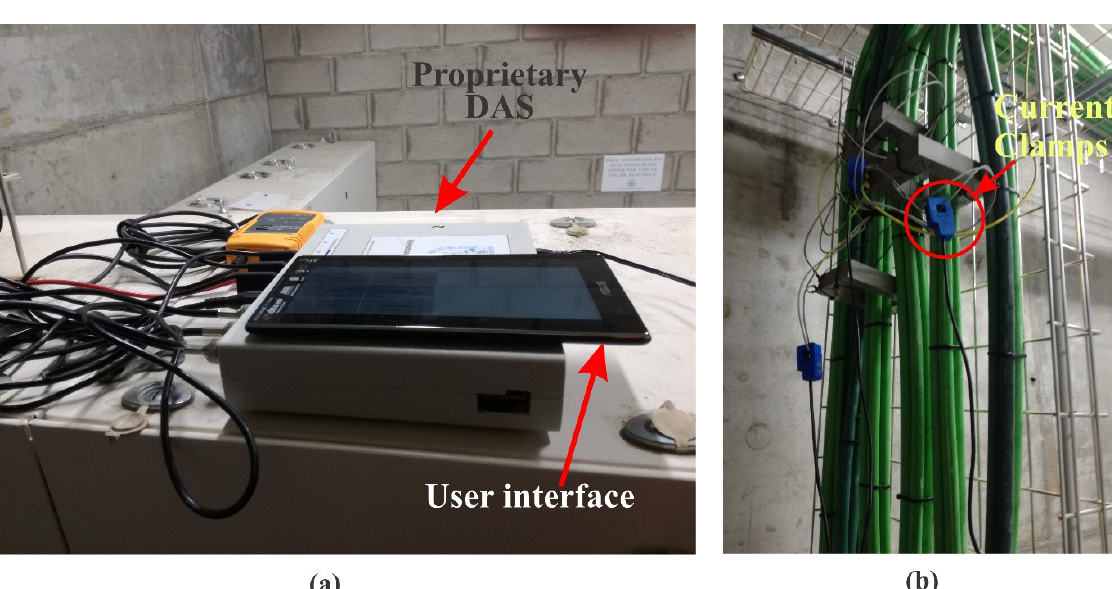
Figure 5. Description of the ( a ) Proprietary DAS with user interface; and ( b ) placement of the current clamps in the secondary winding of measurement current transformers.